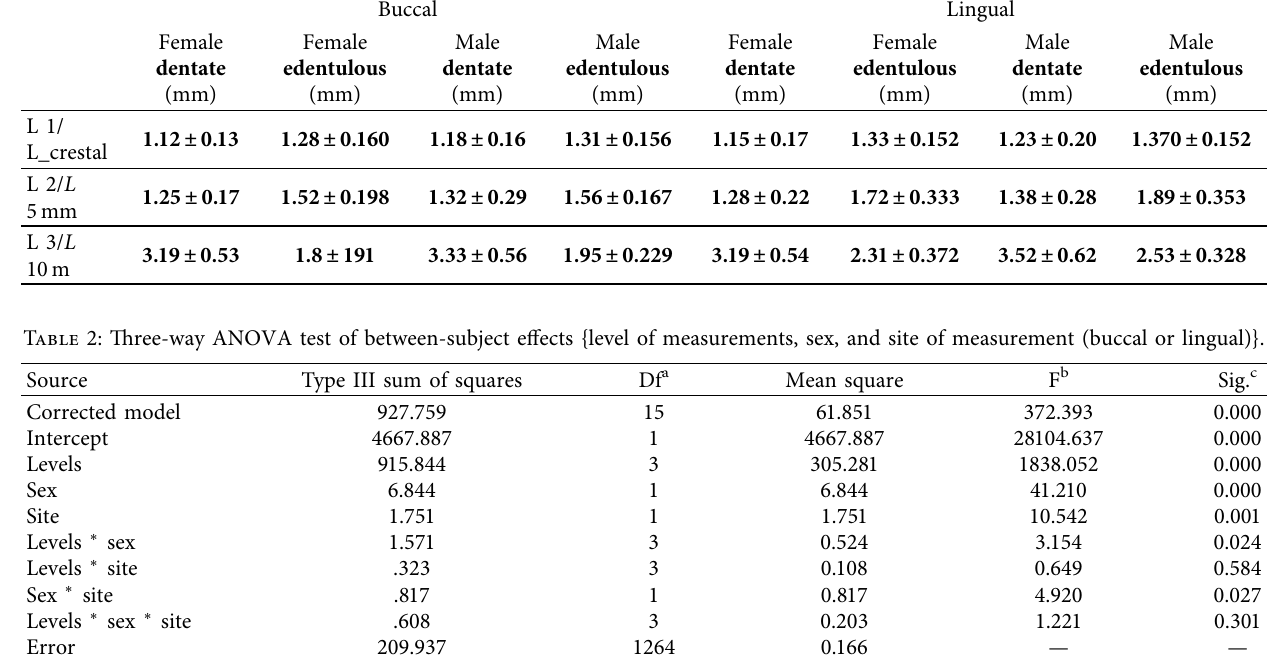
Table 1: Cortical bone thickness in millimeter (mm) of dentate and edentulous sites according to levels in female and male groups ( n � 80). Cortical bone thickness of dentate sites and edentulous sites